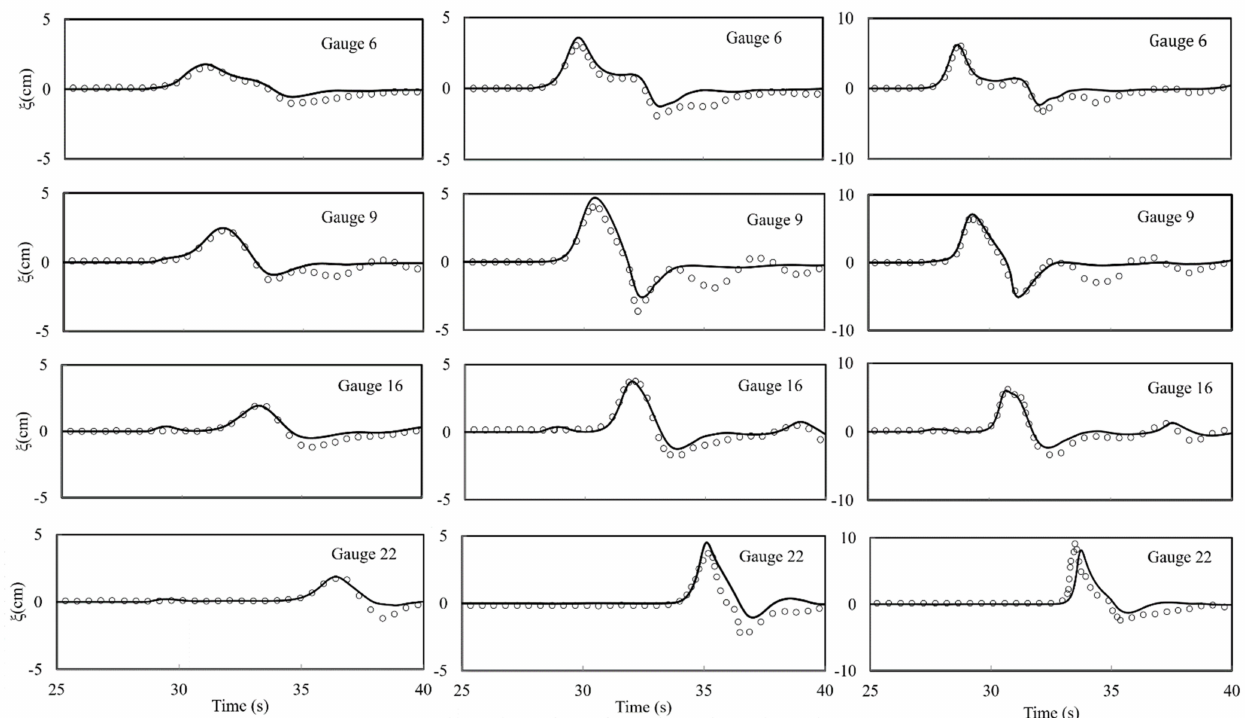
Figure 12. Comparison of simulated and measured free surface elevations for a solitary wave runup on a conical island: A/h = 0.045 (left panel), A/h = 0.096 (middle panel), A/h = 0.181 (right panel). Experimental data (circles), numerical results (solid lines).